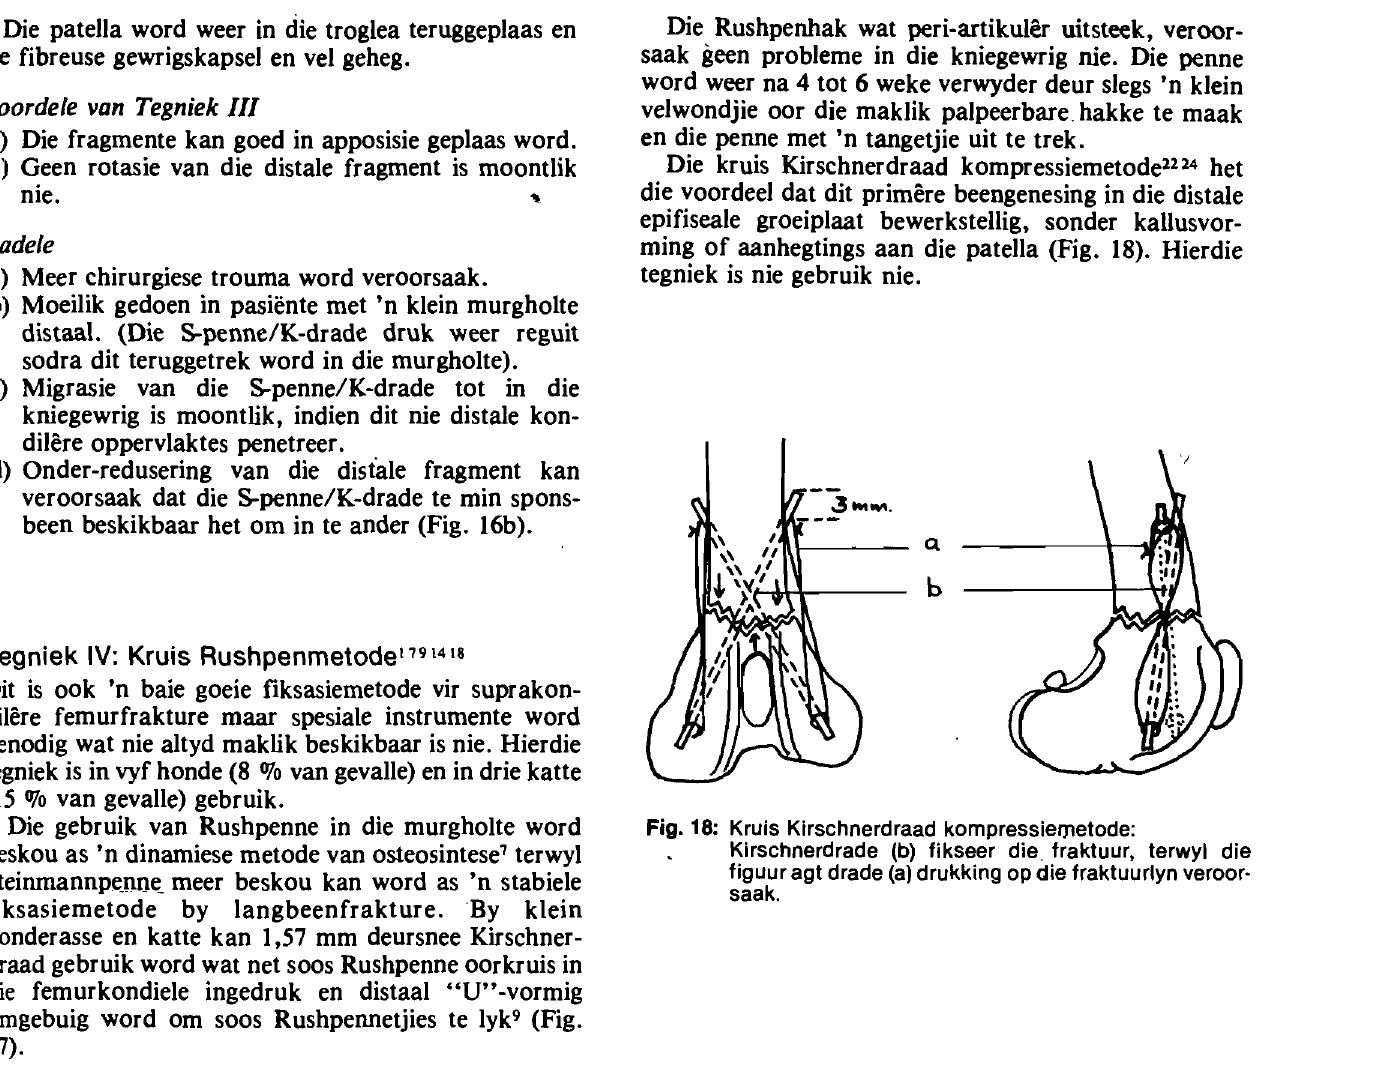
Nadeel van hierdie tegniek is dat lengtegroei baie in geperk word en die femurverkorting is opvallend indien die kruis Kirschnerdrade nie weer na 3 tot 4 weke ver wyder word nie.